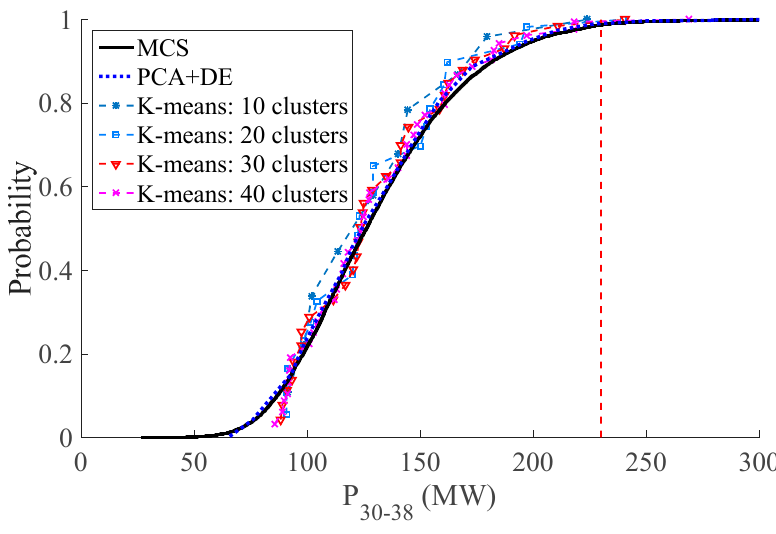
Figure 1. CDFs of active power flow through line 30–38.